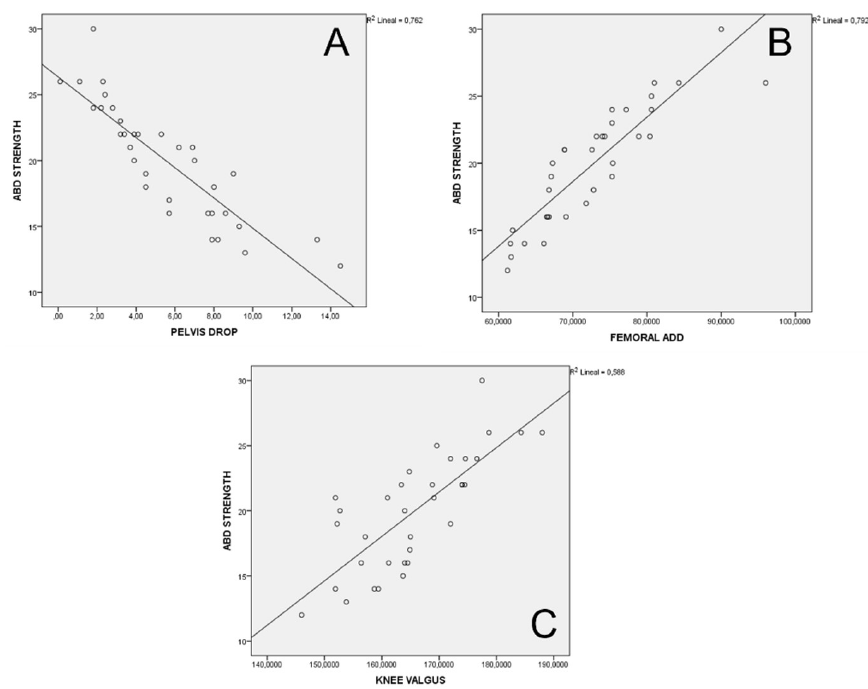
Figure 2. ( A ) Relationship between hip strength and contralateral pelvic drop. ( B ) Relationship Figure 2. ( a ) Relationship between hip strength and contralateral pelvic drop. ( b ) Relationship be- between hip strength and femoral adduction. ( C ) Relationship between hip strength and knee tween hip strength and femoral adduction. ( c ) Relationship between hip strength and knee valgus.